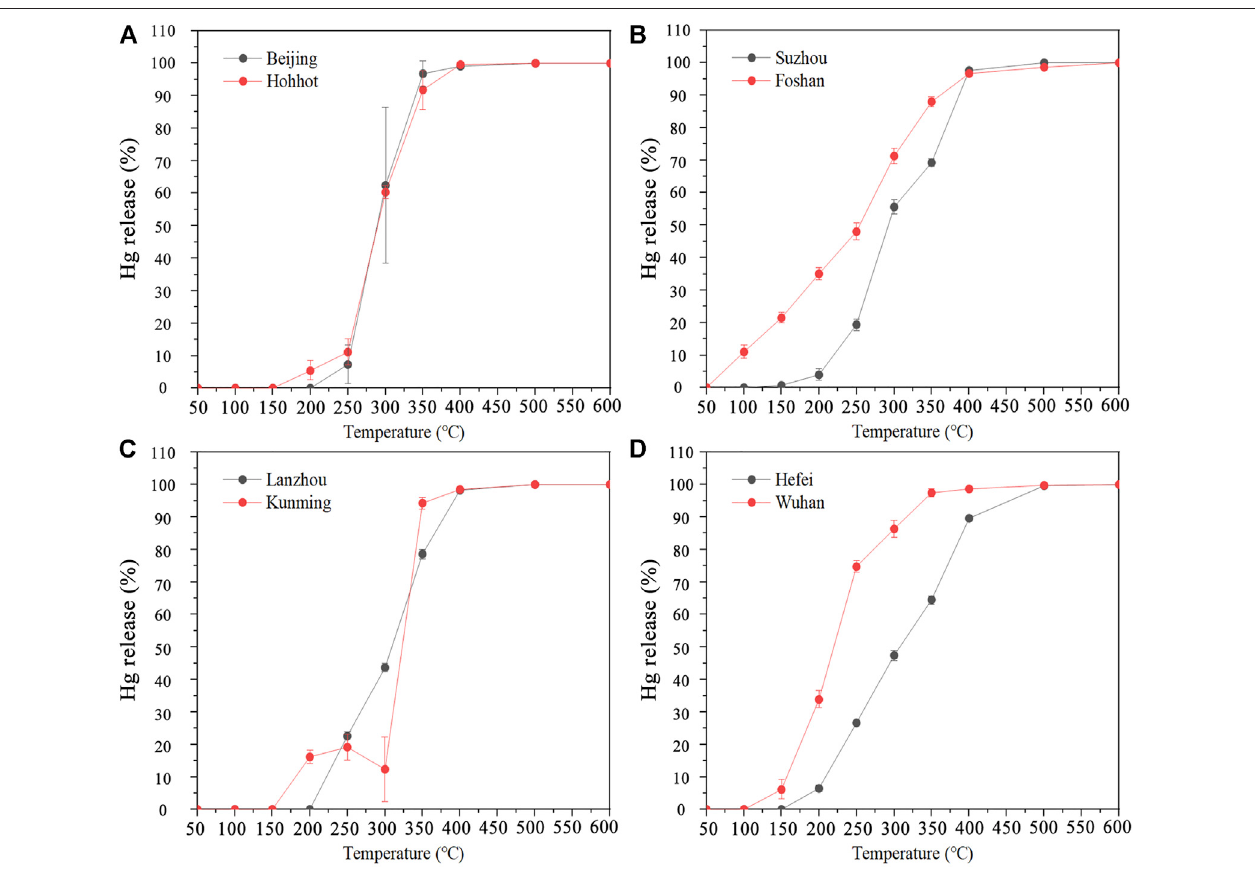
FIGURE 4 | Thermal release of Hg from selected sewage sludge samples. (A) from Northern China; (B) from Eastern China; (C) from Western China; (D) from Central China.